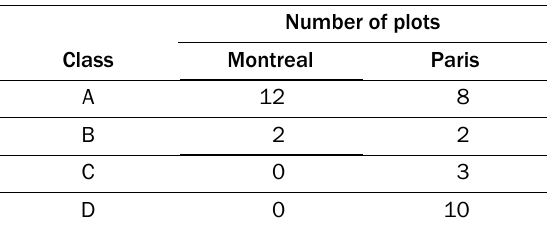
Table 5. Classification of Plots According to